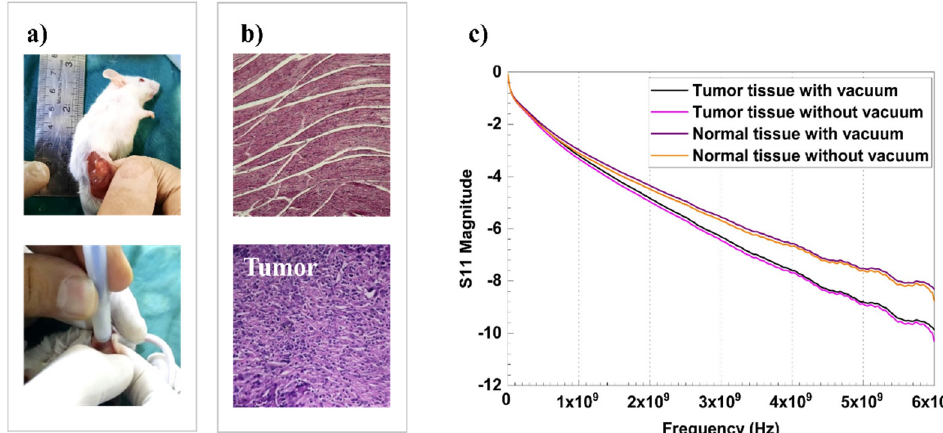
Figure 2. GHz measurement on a mouse model. ( a ) Tumor tissue and applying the GHz probe on it. ( b ) Normal mouse tissue with H&E assay representing the fibrotic connective tissue and cancerous mouse tissue with H&E assay representing a hypercellular region and high nucleus-to-cytoplasm size ratio. ( c ) Frequency-dependent behaviour of S 11 parameter for normal and cancerous tissues with or without applying suction force.